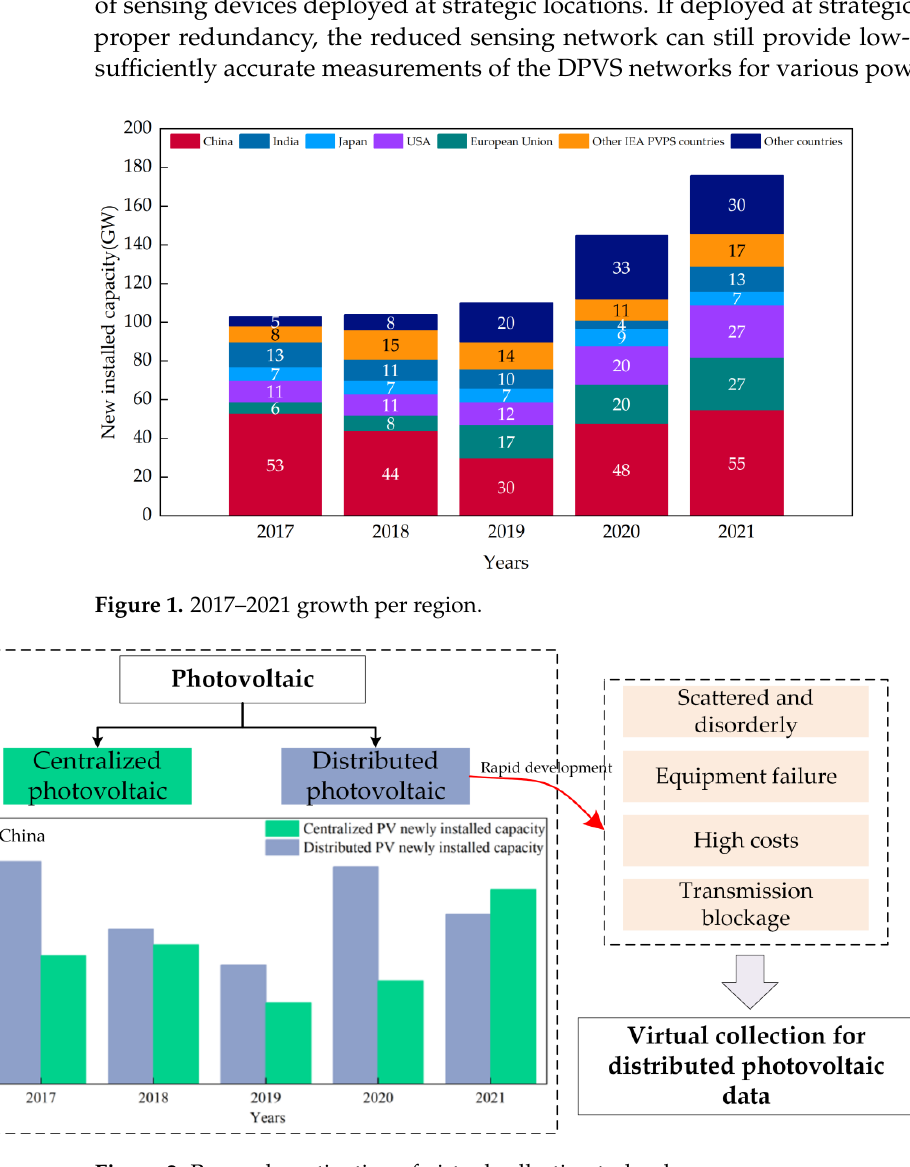
Figure 2. Research motivation of virtual collection technology.